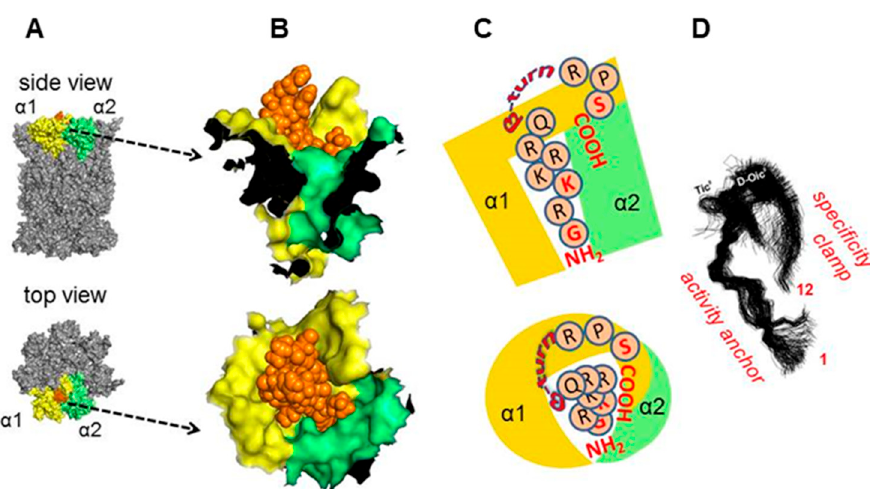
Figure 6. Molecular docking (Rhodium ® ) of (5) to the human 20S (pdb: 5LE5; [35]), pointed to the α 1 / α 2 pocket as the preferred binding site. ( A ) Surface rendering of a fragment of the α face with (5) protruding from the pocket; below– α face with orange colored (5) and α 1 / α 2. ( B ) Zoom-in of proposed positioning of (5) in the binding pocket. ( C ) Schematic positioning of (5) in the α face binding pocket. ( D ) Molecular dynamics simulation of (5) (from [24]) with putative functional significance of the N-terminal and C-terminal fragments for interactions with the proteasome.